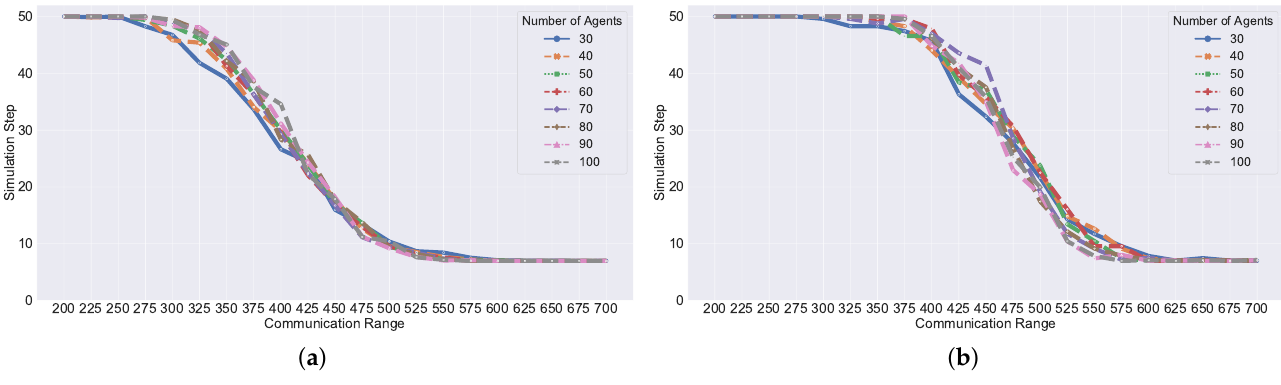
Figure 18. The simulation duration with half swarm size threshold. ( a ) Our proposed method with respect to different swarm size. ( b ) The Raft-based method with respect to different swarm